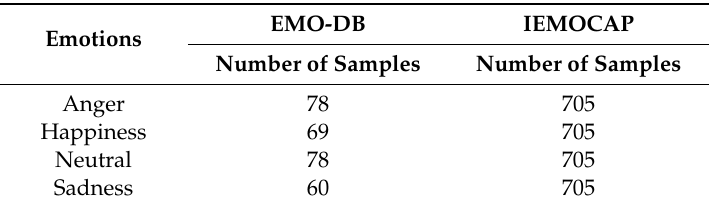
Table 2. Detailed information about the databases, emotion categories, and the number of samples in each emotion